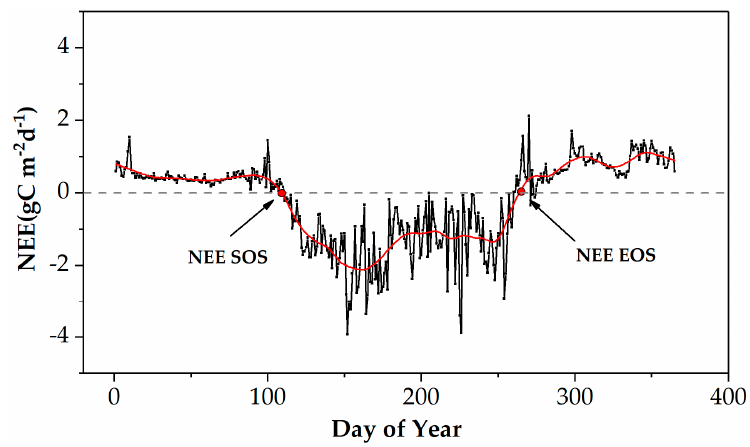
Figure 3. Method for extracting phenological parameters based on net ecosystem exchange (NEE) observation data for FLUXNET sites.